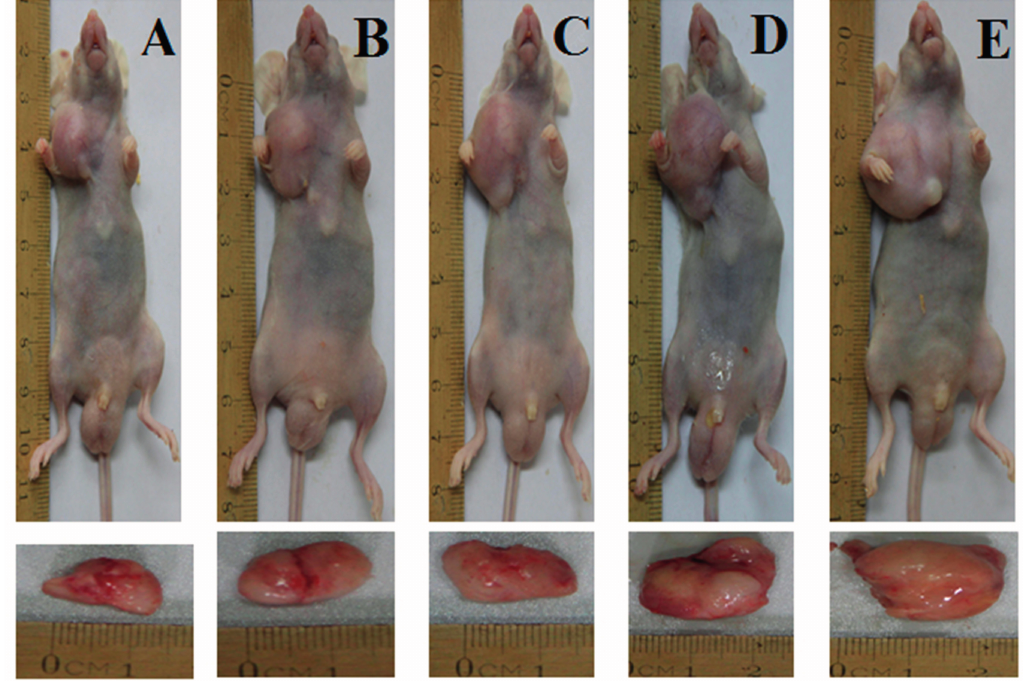
Figure 2. Antitumor effect of myricanol on A549 cells in nude mice. Tumor xenografts from A549 cells were established in athymic nude mice in the flanks and were treated with either myricanol or PEG-400 (vehicle control) for 14 days consecutively. ( A ) Myricanol with 40 mg/kg; ( B ) myricanol with 20 mg/kg; ( C ) myricanol with 10 mg/kg; ( D ) vehicle control group; and ( E ) tumor model group. Table 1. Antitumor effect of myricanol on an A549 cell xenograft model ( n = 8, x ± SD). Body Weight (g) Group and dose Tumor Weight (g) TIR (%) Begin End Myricanol (40